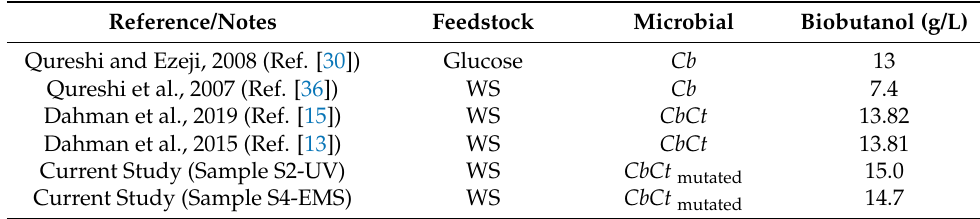
Table 3. Biobutanol production comparative analysis table with previously published